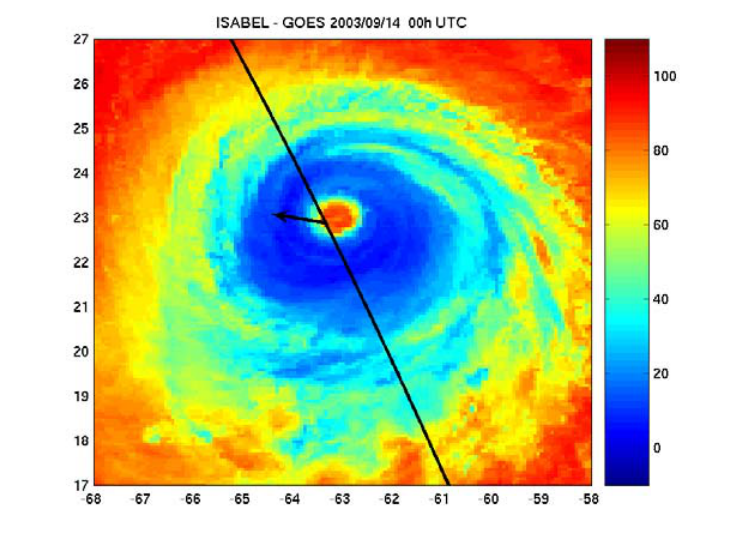
Figure 3. GOES infrared brightness temperatures measured in TC Isabel and the Jason altimeter ground track in black. The arrow indicates the direction of the cyclone